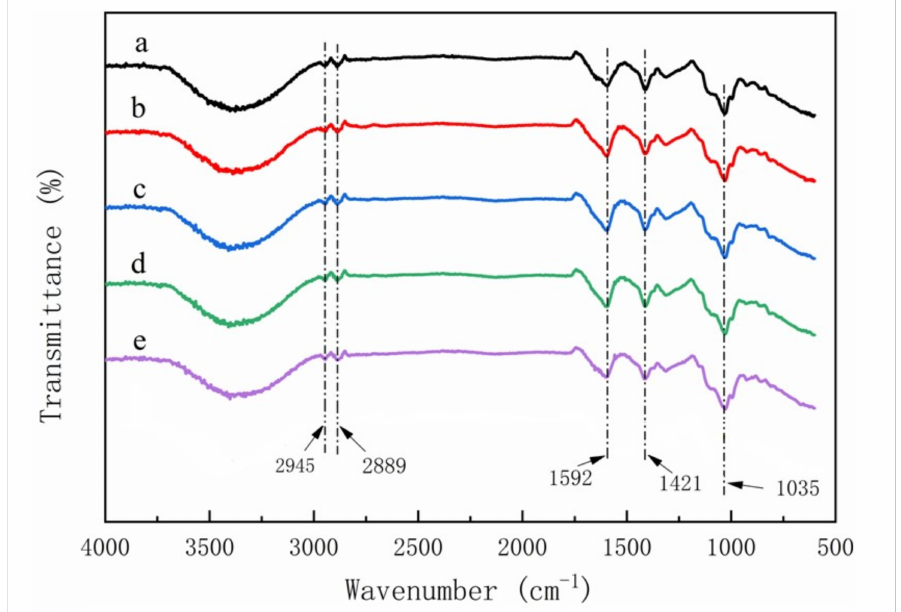
Figure 9. FTIR spectra of CMC composite films derived from ( a ) pine wood, ( b ) bamboo culm, ( c ) pine needles, ( d ) bamboo leaves, or ( e ) hemp hurd.